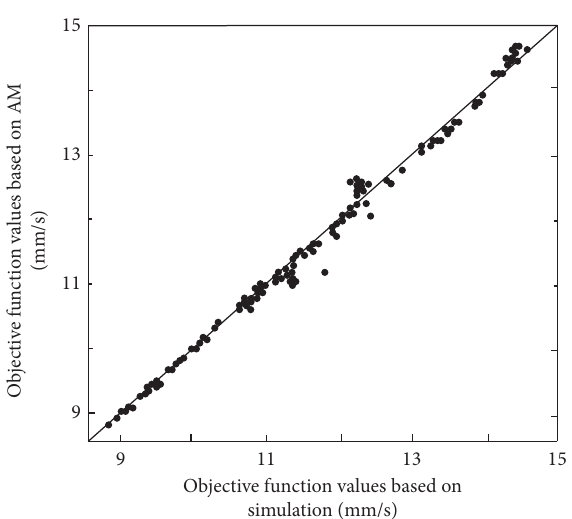
Figure 15: Comparison between AM (RBF) and simulation results for 􏽥 μ f .